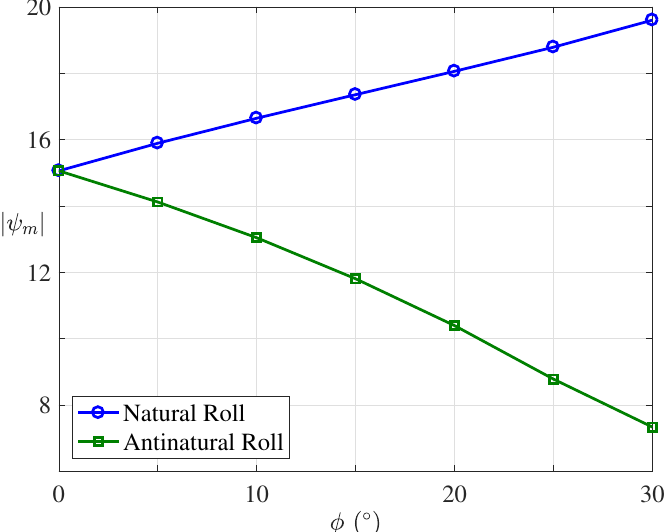
Figure 7. Magnitude of ψ m for steady convective states as a function of φ at Ra = 500 and L = 2. ψ m denotes the extremum ψ value corresponding to the natural roll with max( ψ ) (positive) and antinatural roll with min( ψ ) (negative). As φ is increased, the natural-roll motion is intensified, while the antinatural-roll motion is